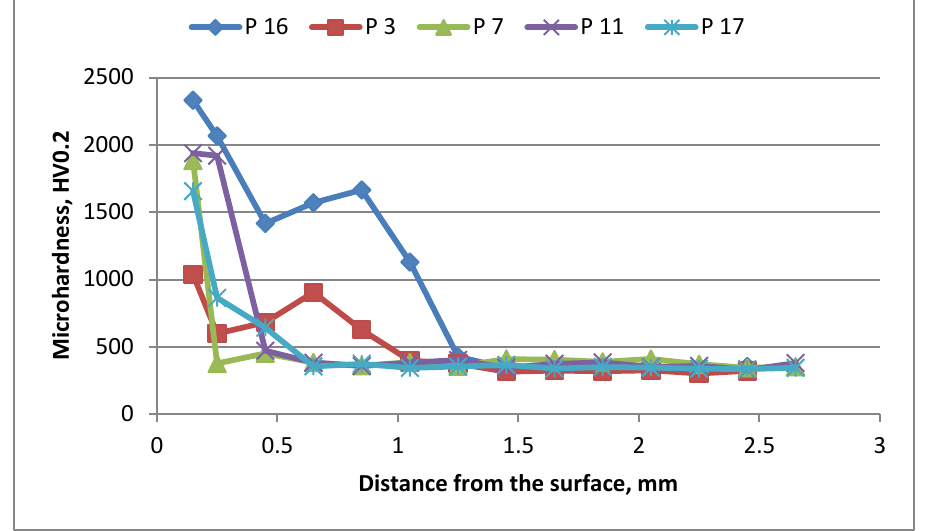
Figure 13. Microhardness distribution on the cross-section of surface layers after laser gas nitriding of titanium alloy Ti6Al4V specimen 3.0 mm thick by HPDDL laser (Table